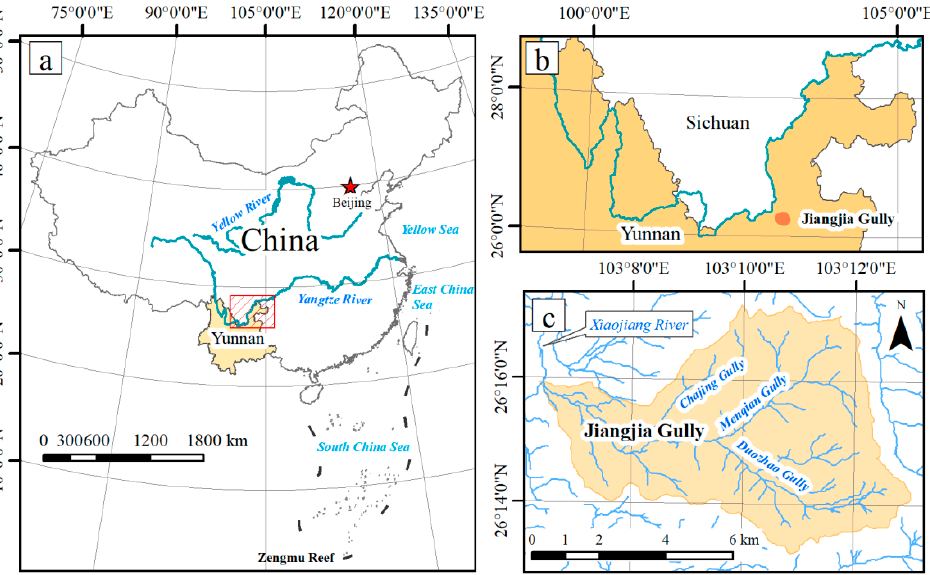
Figure 1. Location of the JJG. ( a ) Location of Northeast Yunnan in China; ( b ) JJG’s location in Northeast Yunnan. ( c ) JJG watershed and its main river network.